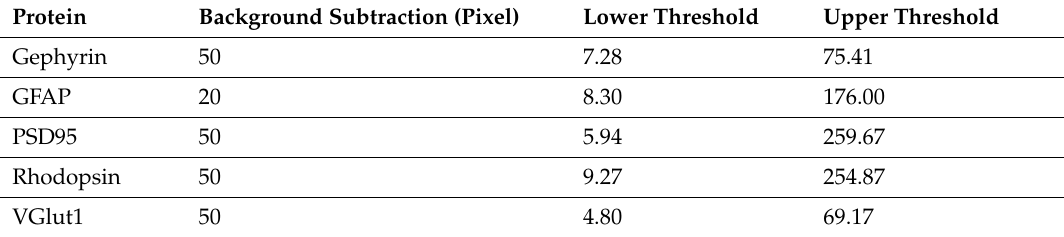
Table 2. Adjustments of ImageJ macro for the area analysis. The background subtraction as well as the lower and the upper thresholds are